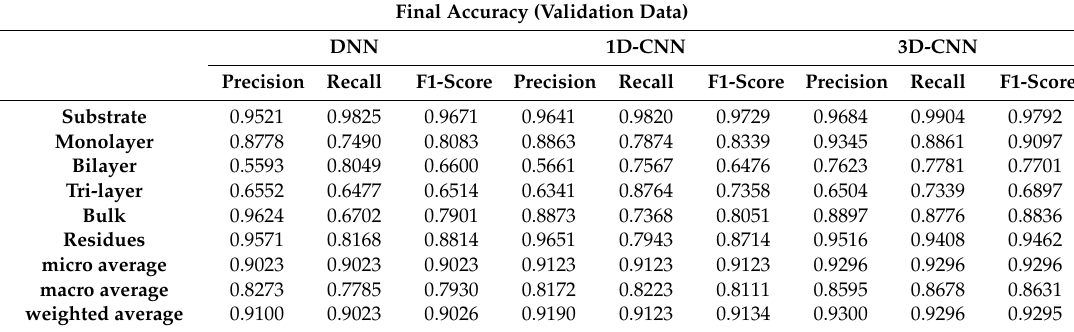
Figure 4f–h present the prediction results for the new data (new pending data) under three models (color classification image), respectively. The results from the region of interest (ROI) in the training data indicate that the DNN and 1D-CNN models cannot accurately predict the damaged region